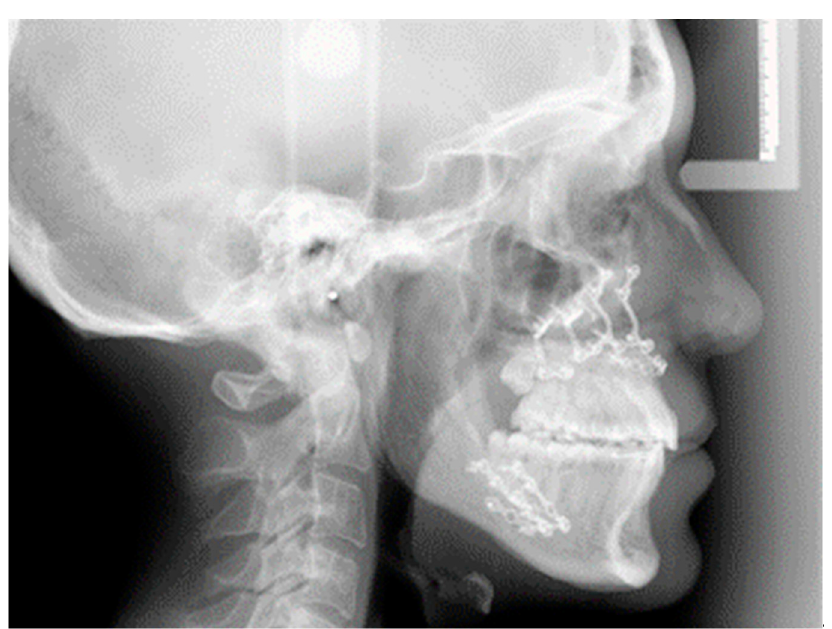
Figure 3. Post-surgery-lateral teleradiograph of a CLP young man .